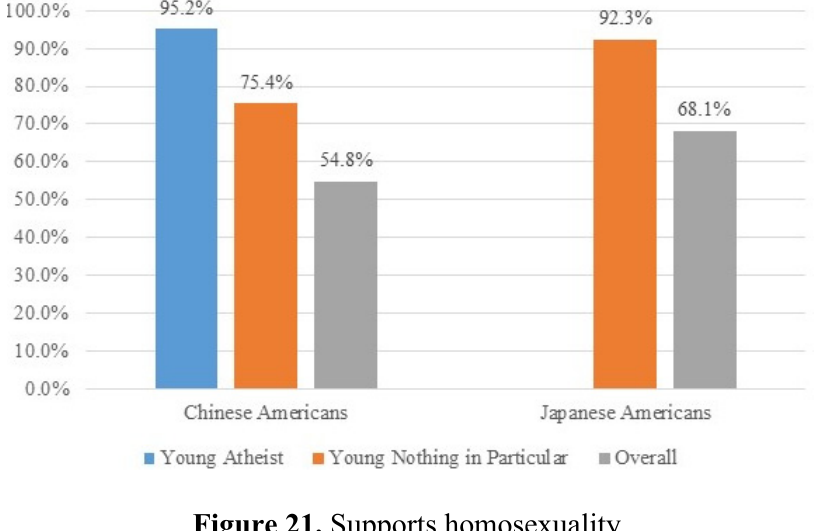
Figure 21. Supports